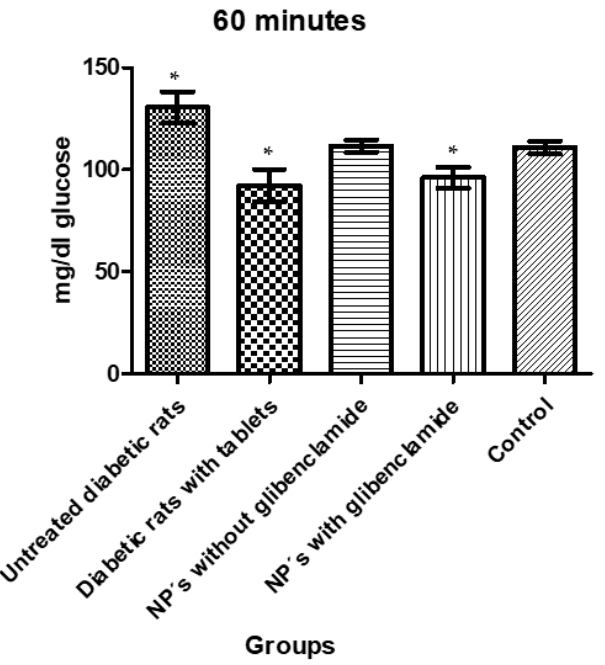
Figure 18. Glucose levels 60 min after administration of a glucose solution and glibenclamide treatments. The asterisks (*) represent a statistically significant difference between groups ( p < 0.05).